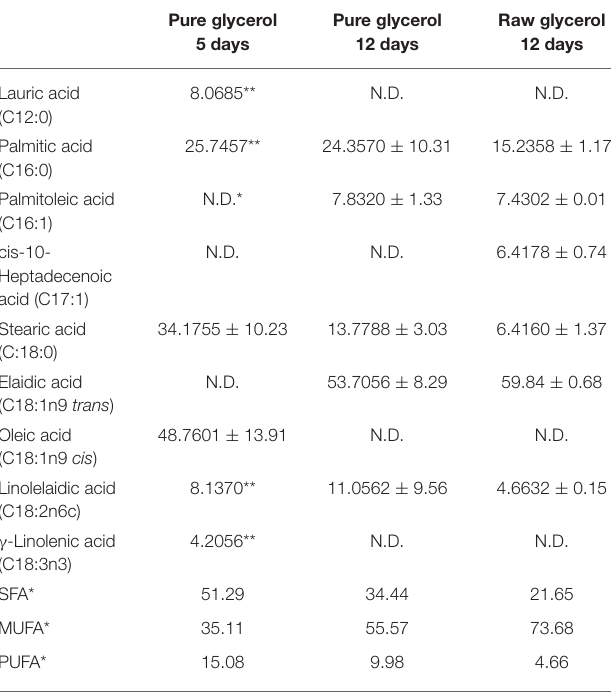
TABLE 5 | Fatty acid methyl esters profile of lipids produced by M. guilliermondii BI281 grown in pure glycerol (5 and 12 days) or raw glycerol (12 days). Pure glycerol Pure glycerol Raw glycerol 5 days 12 days 12